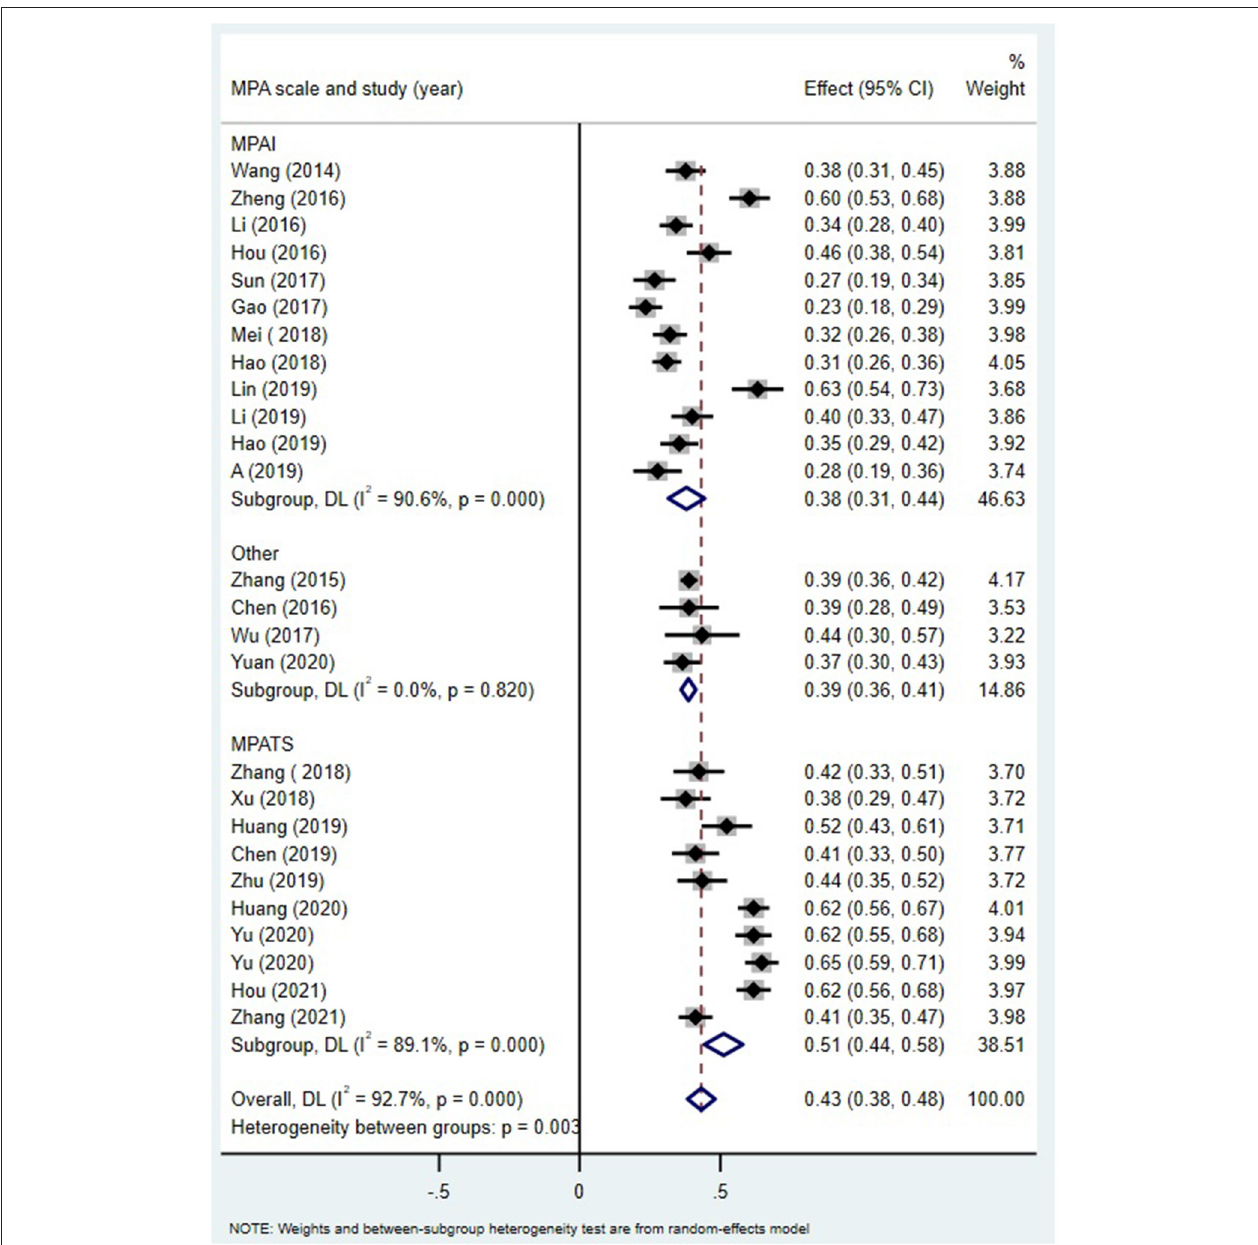
FIGURE 3 | MPA and alexithymia: an analysis of the moderating effects of the MPA measurement